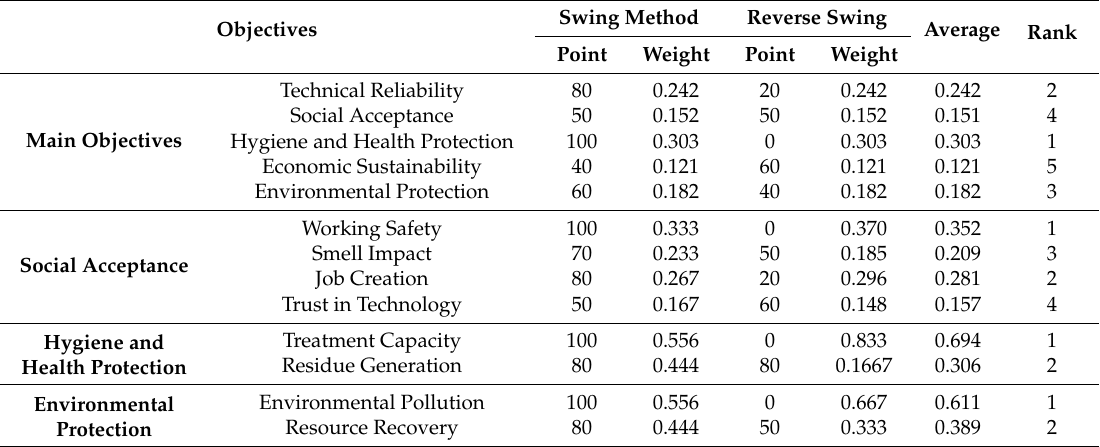
Table 4. BCC Director of Health and Social Services’ weights and ranking of